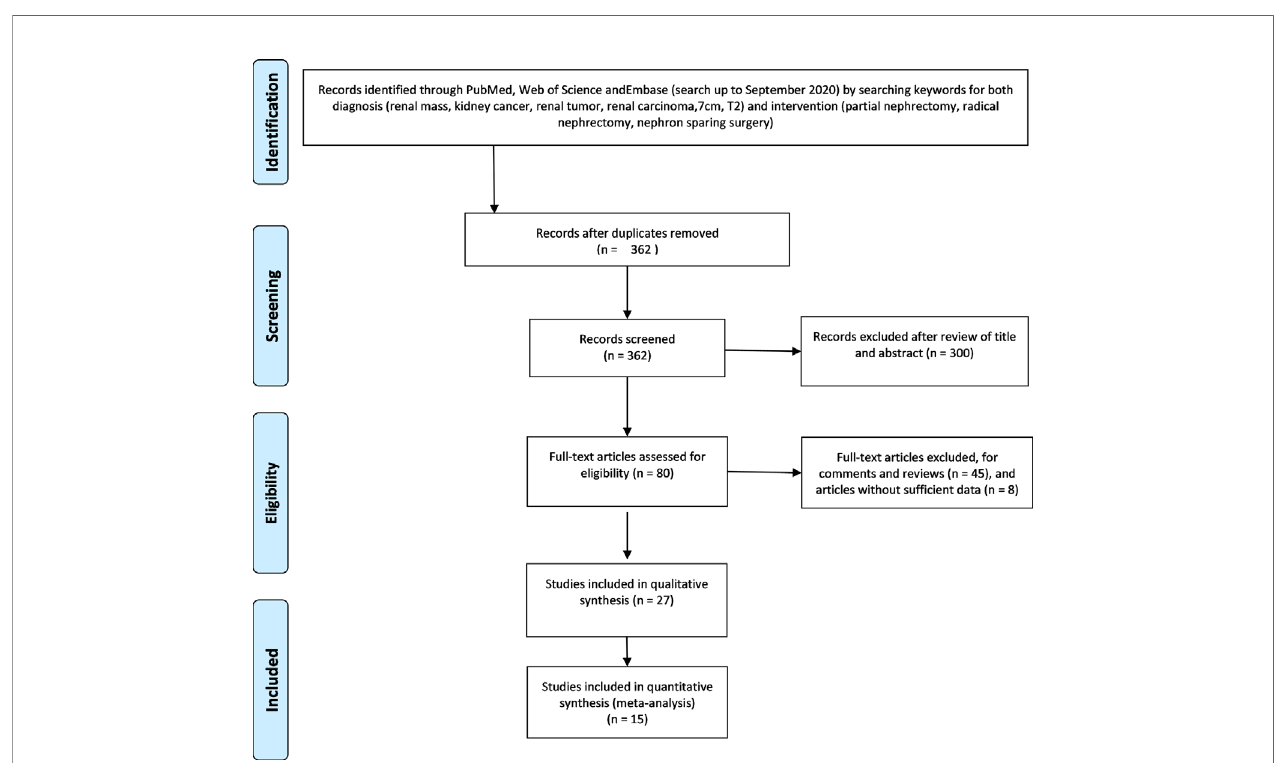
FIGURE 1 | PRISMA fl ow diagram of the search strategy and identi fi cation of relevant studies